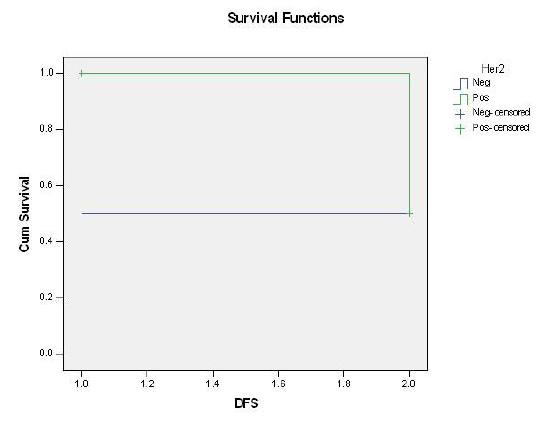
Fig. 3. HER2/neu overexpression and disease-free survival